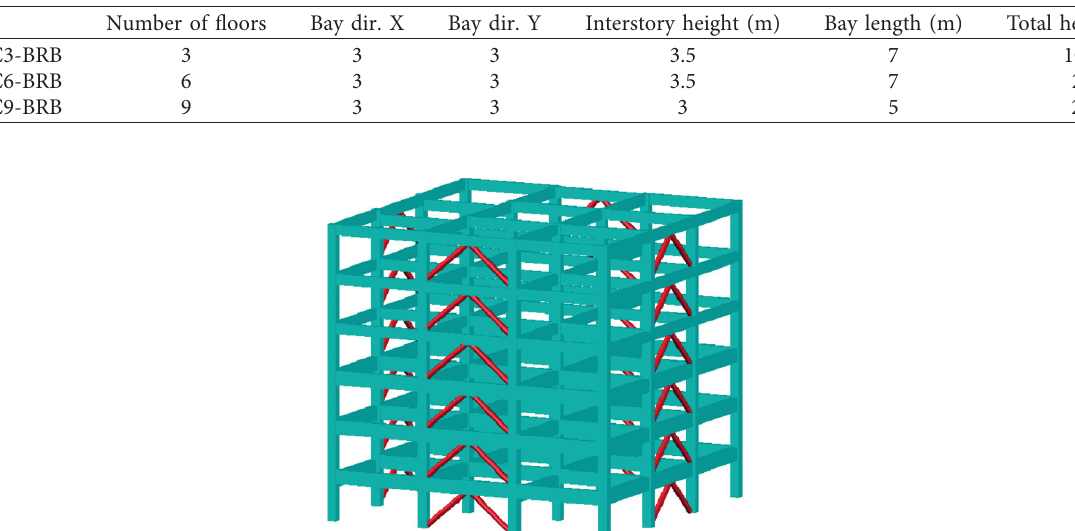
Table 1: Main geometric characteristics of the designed structural models.